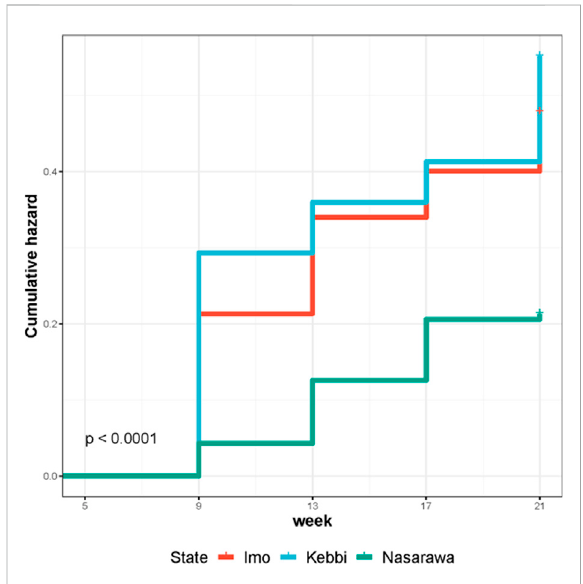
FIGURE 3 Effect of agro-ecological zone on the cumulative hazard of birds (5 – 21